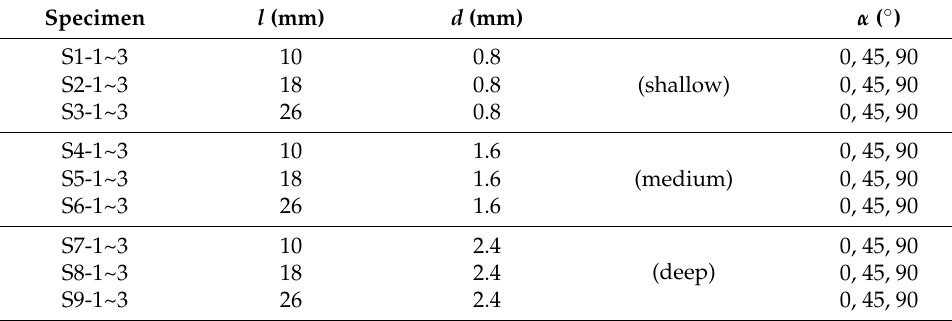
Table 1. The test matrix for laminates with prefabricated surface cracks.